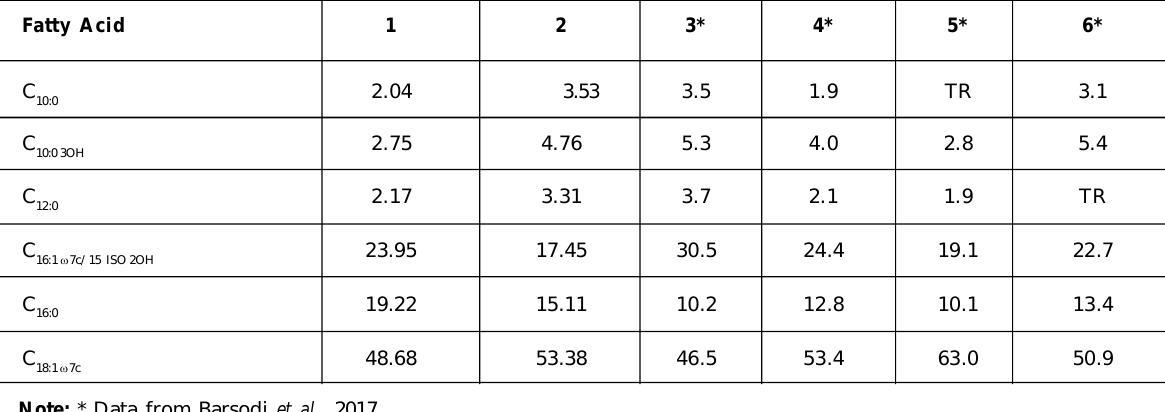
Table 2: Fatty acid composition of the isolates: 1, E-48 T ; 2, Nitrincola lacisaponensins (DSM 16316 T ) (This study); 3, N. alkalisediminis JCM 19317 T ( Joshi et al., 2016 ) 4, N. nitratireducens JCM 18788 T (Singh et al.,